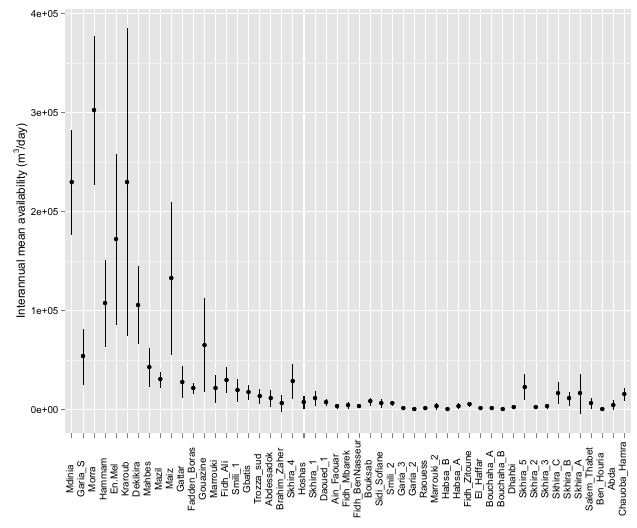
Figure 16. Mean interannual availability over 2007–2014 per lake over the whole year displayed as the mean ± 1 standard deviation.